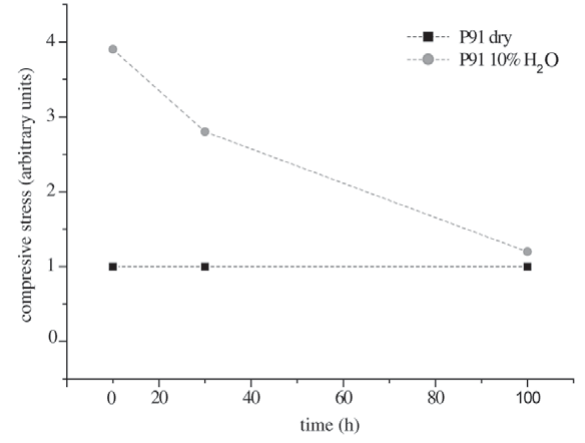
Figure 16. Relative level of the oxide scale stresses for P91 in dry synthetic air and air with 10% H 2